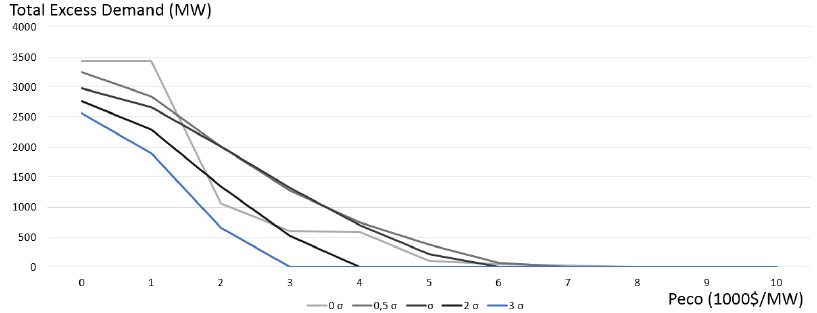
Figure 11. Variation of the total excess Demand with respect to P eco and σ (own results).